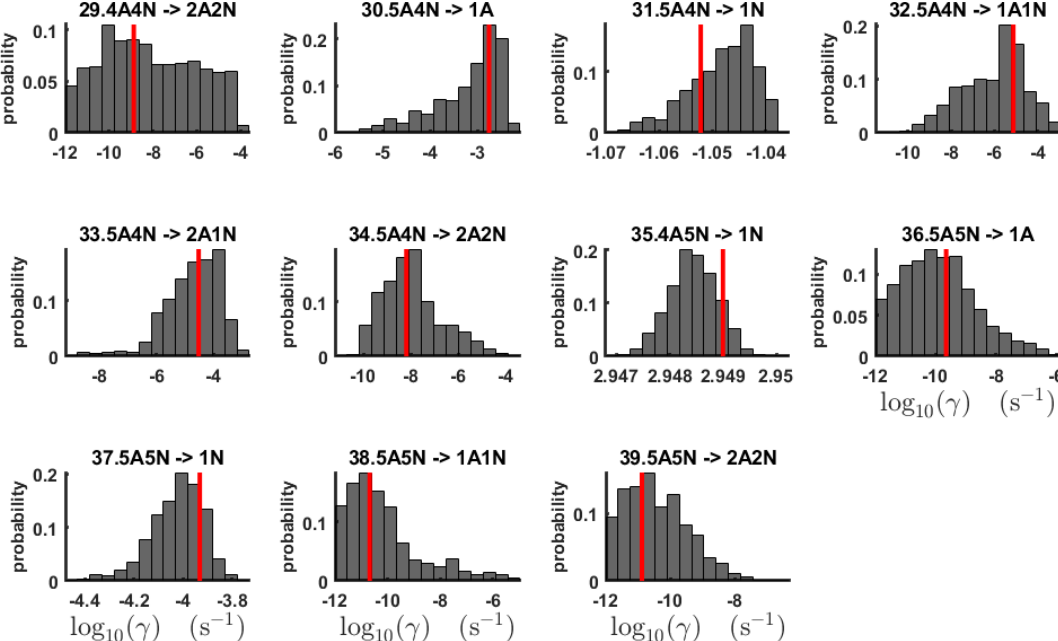
Figure 7. One-dimensional marginal posterior distributions (for parameter indexes ranging from 29 to 39) of the base 10 logarithm of the evaporation rates (units given in s − 1 ) determined from time-dependent measurements of the cluster concentrations with time resolution comprising 1.5min at the temperature 278K. Red lines denote the baseline values from Olenius et al. (2013b) used to generate the synthetic data. The notation xAyN corresponds to a cluster with x sulfuric acid and y ammonia